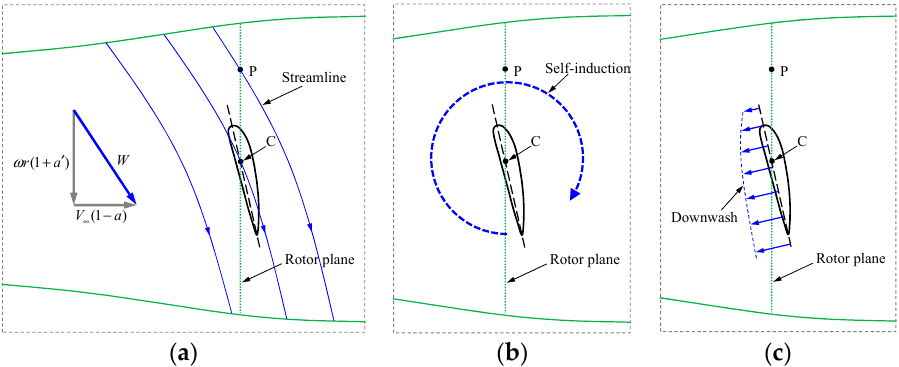
Figure 1. Different kinds of inductions in the flattened section of a certain radial location: ( a ) Bent streamlines because of disc-induction; ( b ) self-induction; ( c ) downwash because of 3D-induction. Table 1. List of the angle of attack (AoA) determination methods and their corresponding kinds of AoA.